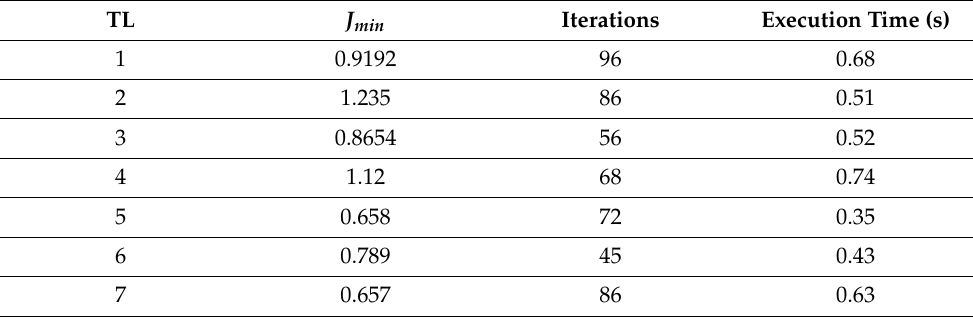
Table 1. Performance of the WOA for parameter estimation of seven